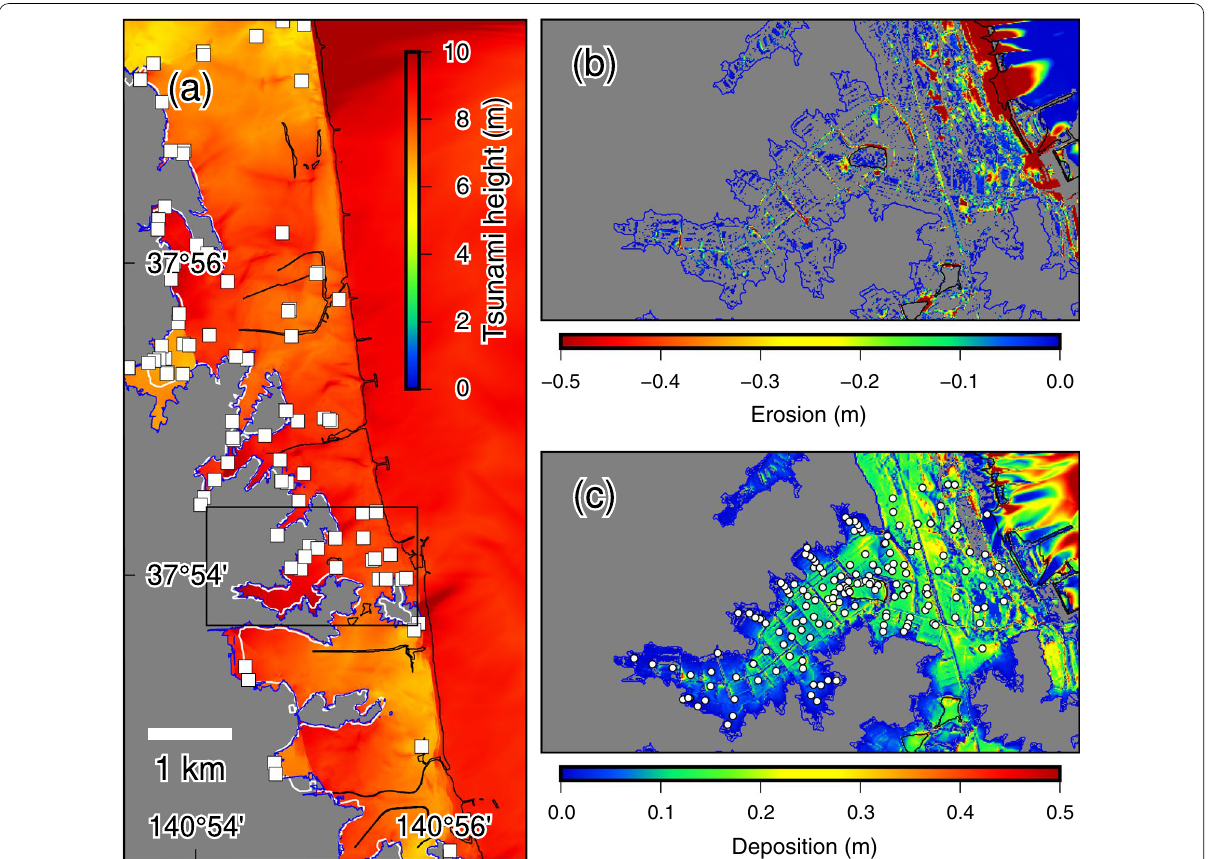
Fig. 4 Results of the reference simulation. a Distribution of the maximum tsunami height in Domain R6. Blue and white lines represent simulated and observed inundation limits, respectively. Black frame shows the spatial range of Fig. 2b and c. b Distribution of erosion depth near the Suijin-numa pond. Black line indicates the 0 m contour after the simulation. c Distribution of deposition